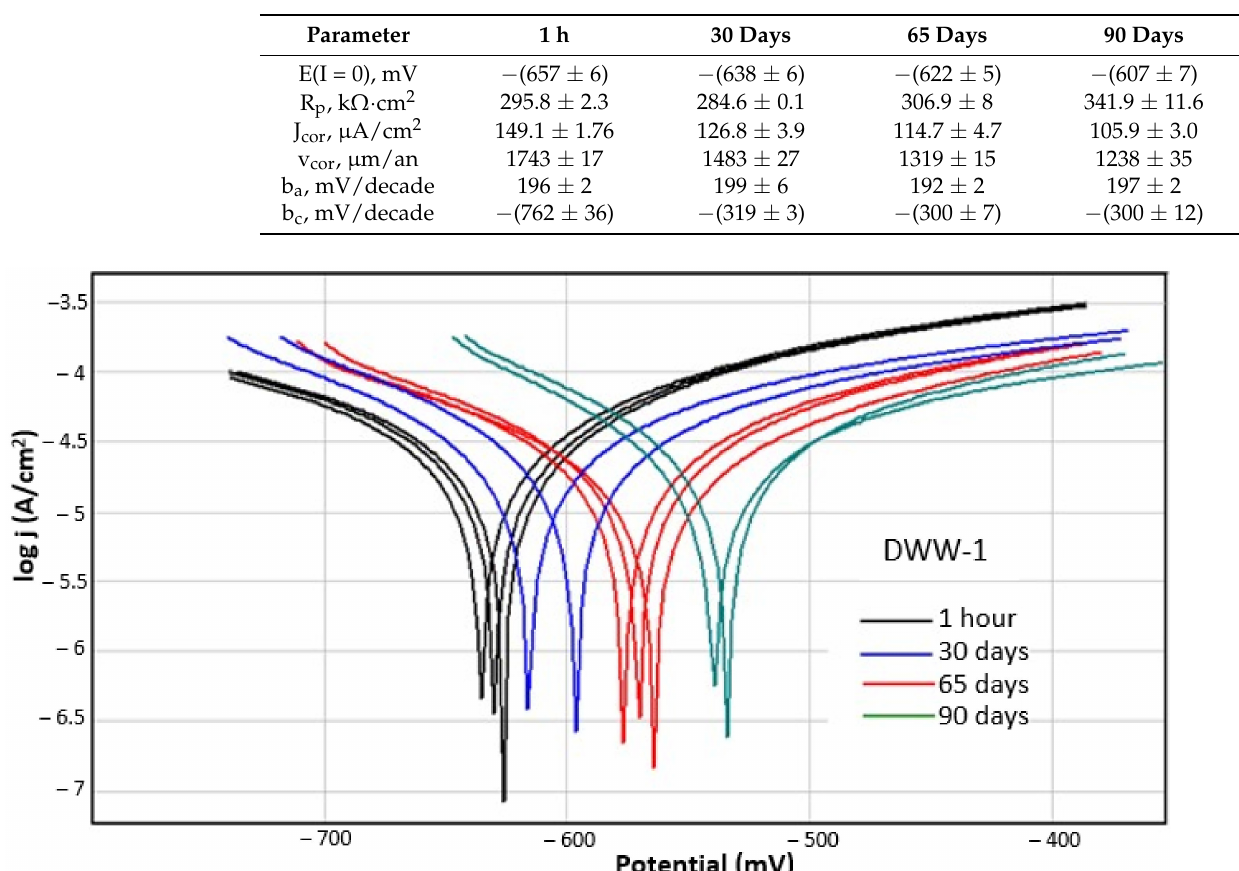
Table 5. Instantaneous corrosion process parameters for samples immersed in DWW-3.